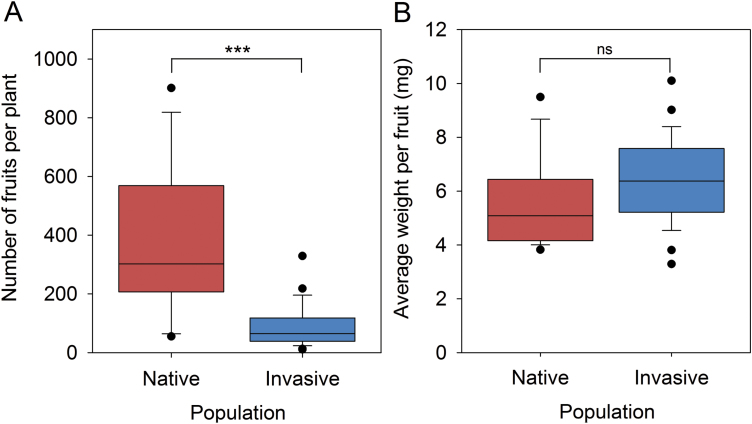
Reproductive output. (A) Number of fruits produced per plant for the native population (red, n=15 plants, average: 381 fruits per plant), and the invasive population (blue, n=27 plants, average: 91 fruits per plant). (B) Average fruit weight for the native population (red, n=15, average: 5.5 mg) and the invasive population (blue, n=27 plants, average: 6.3 mg). Box plots show the first, second, and third quartiles (the box), the 10th and 90th percentiles (the whiskers), and outliers as individual dots. Mann–Whitney U-tests were performed to test for significant differences between groups (ns P>0.05, ***P<0.001; Bonferroni correction was applied with m=17 to the α of individual comparisons to obtain the indicated overall α values).